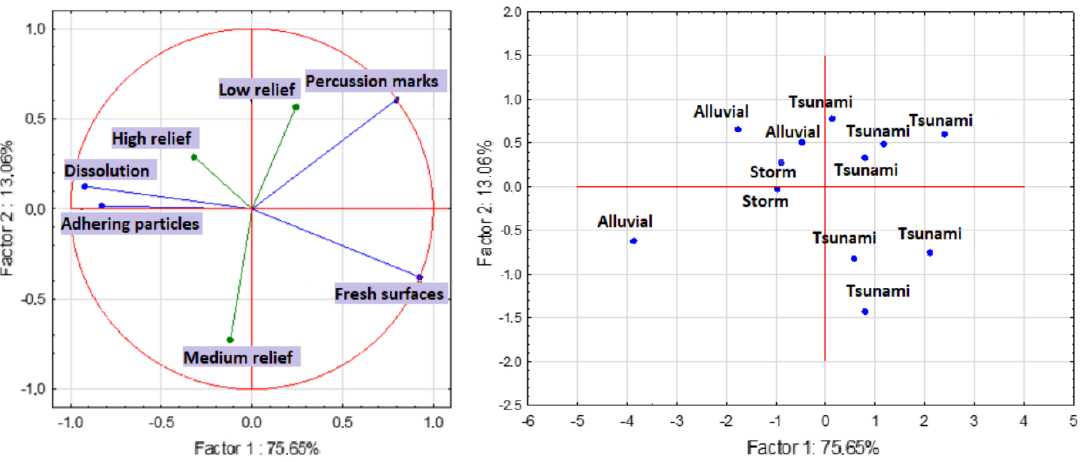
Figure 8. Principal component analysis (PCA) over the 12 samples and 5 microtextural features performed under the new qualitative and semi-quantitative classification of quartz grains (left quadrant). Right quadrant: each group of samples (extreme marine inundations and other sedimentary environments).